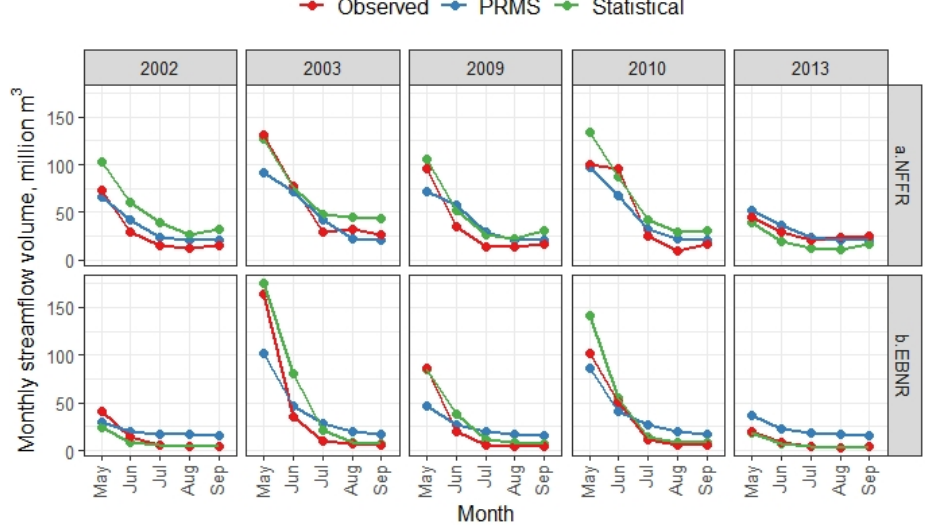
Figure 5. Monthly runoff forecasts: ( a ) North Fork Feather River (NFFR) as inflow to Lake Almanor and ( b ) East Branch of the North Fork (EBNR), generated by two forecasting methods and the observed runoff data. Table 3. The summary of measurements of forecast skill.